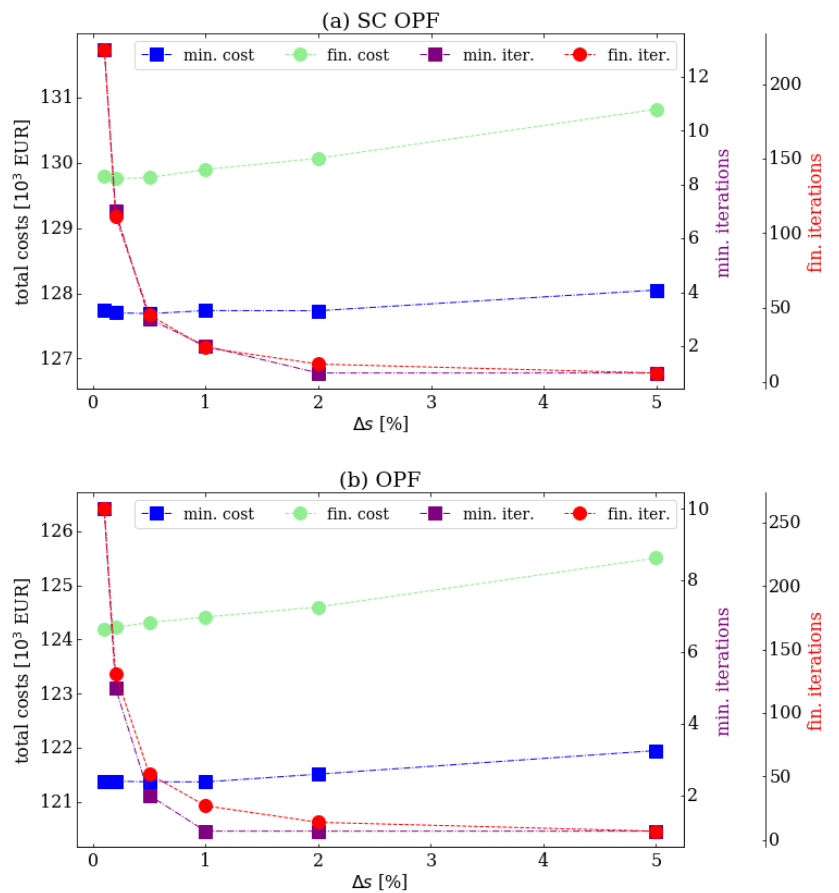
Figure 8. Results of sensitivity analysis for SC OPF ( a ) and OPF ( b ) scenarios, and for two stopping criteria: min.—representing the minimal total cost as in (3) and fin.—representing the case with R th = 0. The total costs for min. (blue) and fin. (green) are plotted with respect to the left vertical axis. The number of iterations (iter.) to reach the stopping criterion for min. (purple) and fin. (red) are plotted with respect to right separate vertical